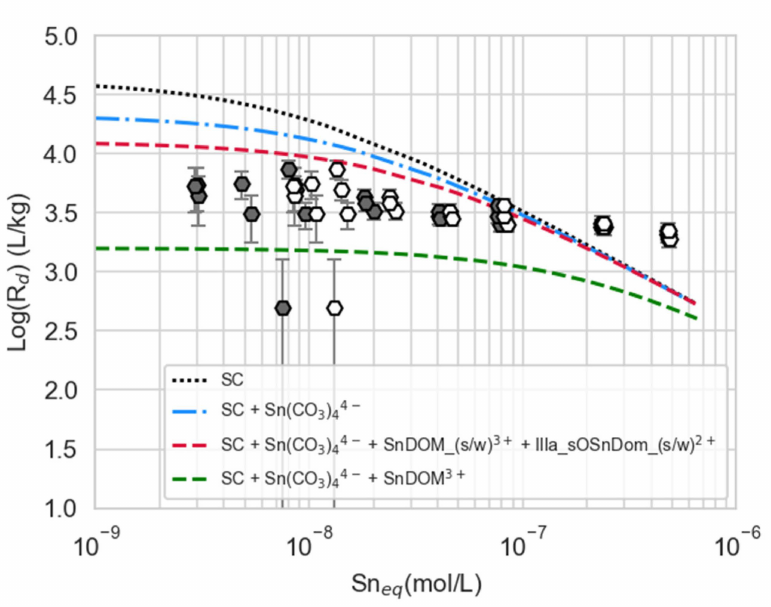
Figure 3. Sorption isotherm of Sn(IV) on Boom Clay in SPRING clay water at pH= 8.41 ± 0.04 and at a solid/liquid ratio of 0.13 ± 0.01 g/L. Grey markers= experimental data, empty markers= experimental data recalculated taking into account the natural Sn concentration such as Sn eq (recalculated) = Sn eq + Sn natural . Black dotted line = 2SPNE SC model ( log K 3 , log K 4 (Table 5), ≡ S s OH (Table 3)), blue dashed line = 2SPNE SC model ( log K 3 , log K 4 (Table 5), ≡ S s OH (Table 3)) + Sn(IV)-carbonate complexation ( log K 5, Table 5), green dashed line = 2SPNE SC model ( log K 3 , log K 4 (Table 5), ≡ S s OH (Table 3)) + Sn(IV)-carbonate complexation ( log K 5 , Table 5) + Sn(IV)-DOM